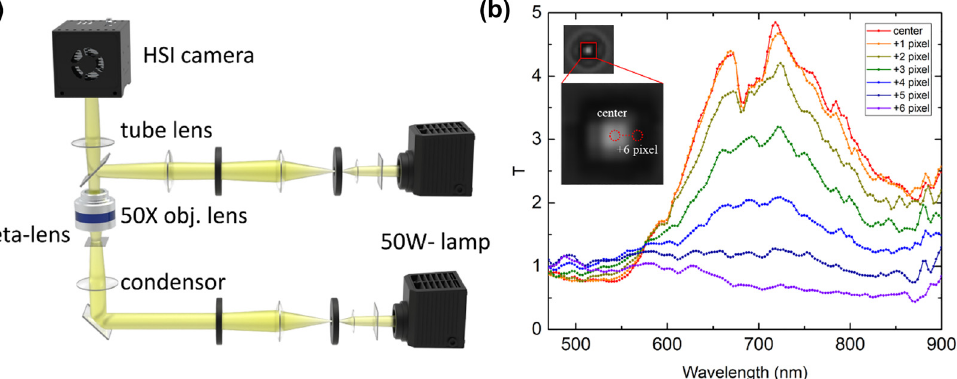
Figure 4: Optical measurement setup and transmission spectrum of axicon metalens. (a) Schematic of the μ -HSI apparatus with a 50 × objective lens. Two 50 W halogen lamps were used for reflection imaging and transmission measurement. (b) Transmission spectra of the axicon metalens along the x direction; x = 0 indicates the center of the HSI lens; x = 6 indicates 6 pixels (on the HSI system) away from the center of the lens.